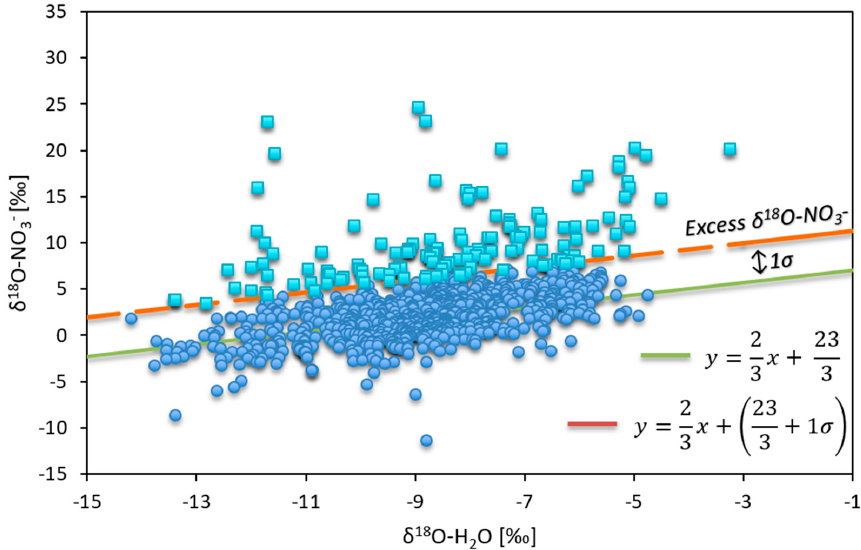
Figure 2. Plotting δ 18 O-H 2 O versus δ 18 O-NO 3 − reveals the relationship between the isotopic composition of oxygen for groundwater and nitrate. Solid green line is modeled after Equation (1), and the dashed orange line labeled ‘Excess δ 18 O-NO 3 − ’ is one positive standard deviation away from the predicted value, and separates the light blue, or ‘excess’